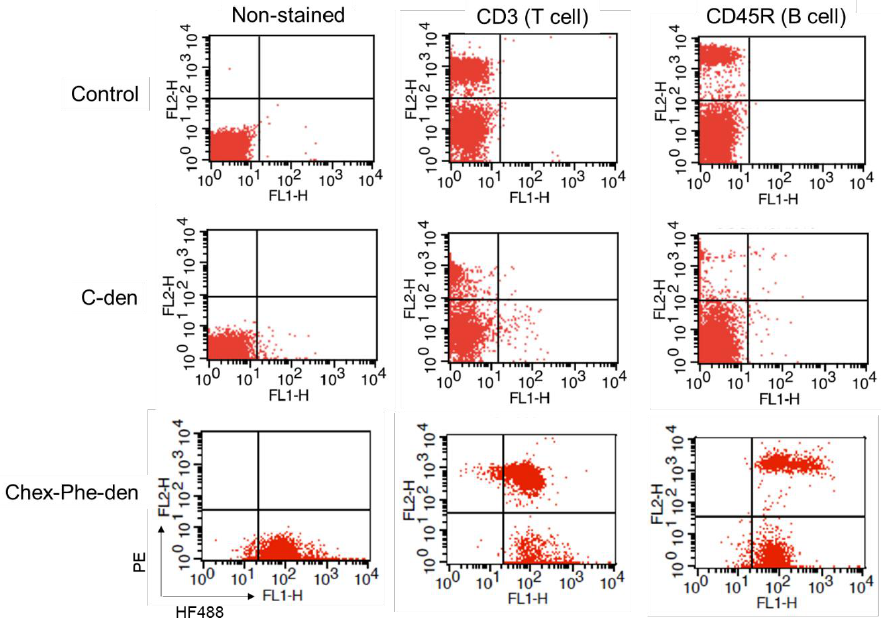
Figure 5. Flow cytometry of PE-stained lymph node-resident lymphocytes in mice injected with the green fluorescent dye-conjugated dendrimers.